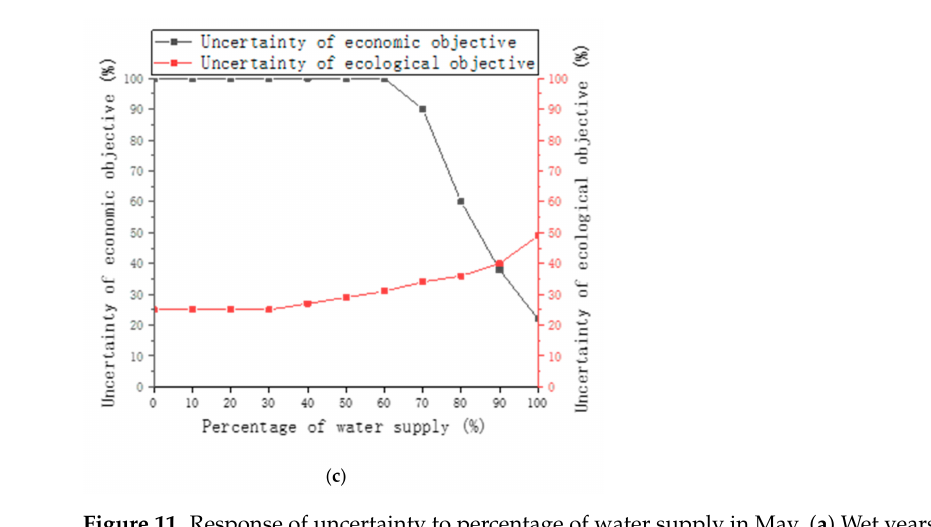
Figure 11. Response of uncertainty to percentage of water supply in May. ( a ) Wet years. ( b ) Normal- flow years. ( c ) Low-flow years.